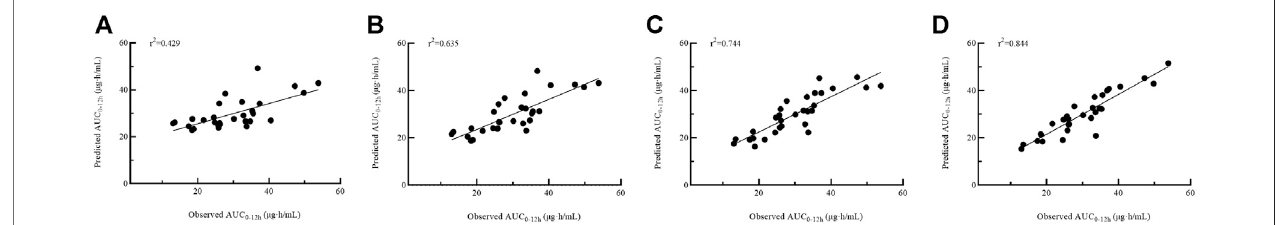
FIGURE 2 | Passing – Bablok regression analysis between the observed AUC 0 – 12h and the predicted AUC 0 – 12h of MPA obtained from model building group using model 1 (A) , model 2 (B) , model 3 (C) and model 4 (D) . AUC 0 – 12h , the area under the 12 h concentration-time curve; MPA, mycophenolic acid.